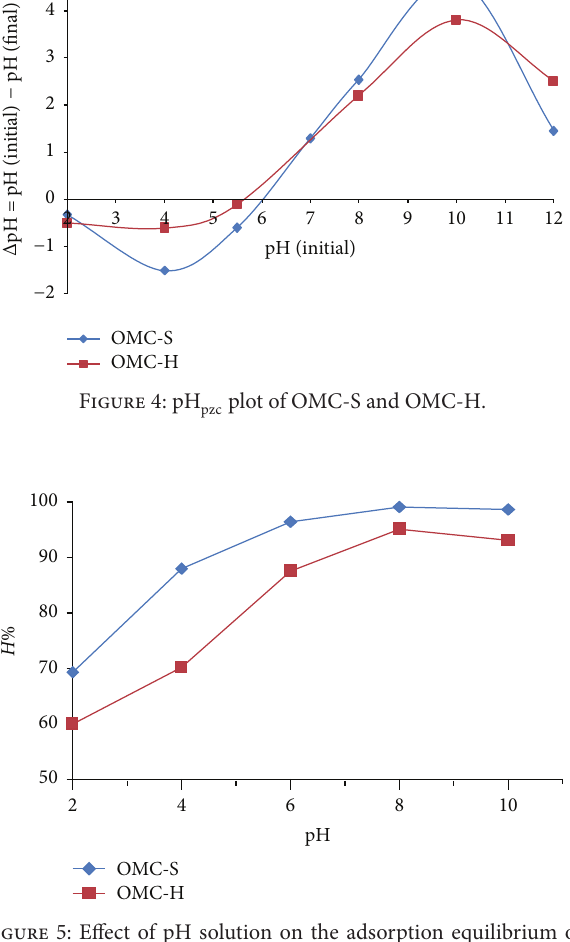
Table 3: Langmuir and Freundlich isotherm constants of OMCs-H and